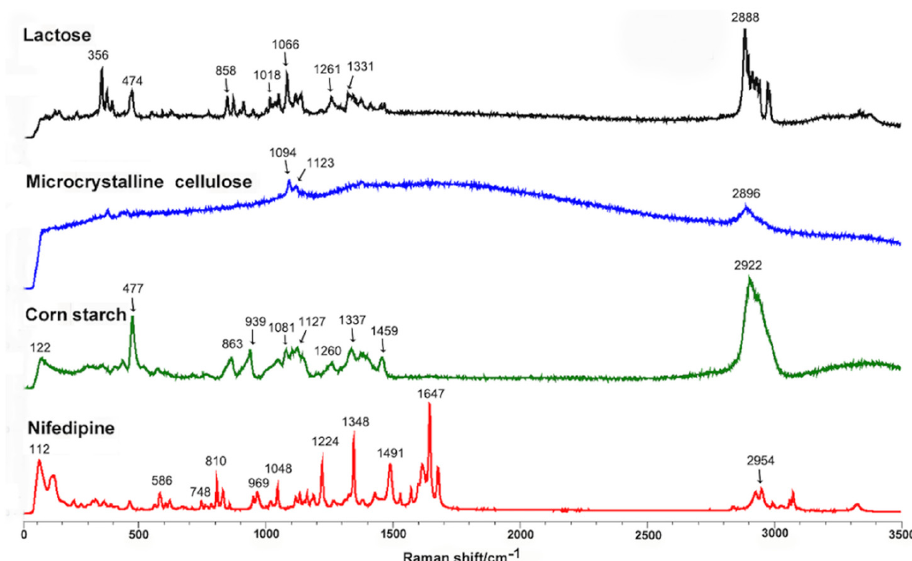
Figure 1. Raman spectra of nifedipine, corn starch, microcrystalline cellulose, and lactose. The characteristic bands are marked: nifedipine, 112, 586, 748, 810, 969, 1048, 1224, 1348, 1491, 1647, and 2954 cm − 1 ; corn starch, 122, 477, 863, 939, 1081, 1127, 1260, 1337, 1459, and 2922 cm − 1 ; microcrystalline cellulose, 1094, 1123, and 2896 cm − 1 ; lactose, 356, 474, 858, 1018, 1066, 1261, 1331, and 2888 cm − 1